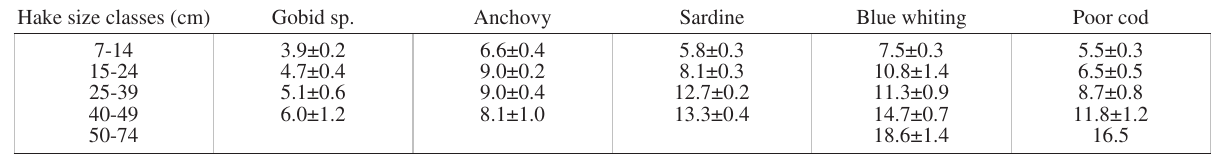
Table 3. – Mean size ± SE of the main fish prey eaten per hake size class. Hake size classes (cm)